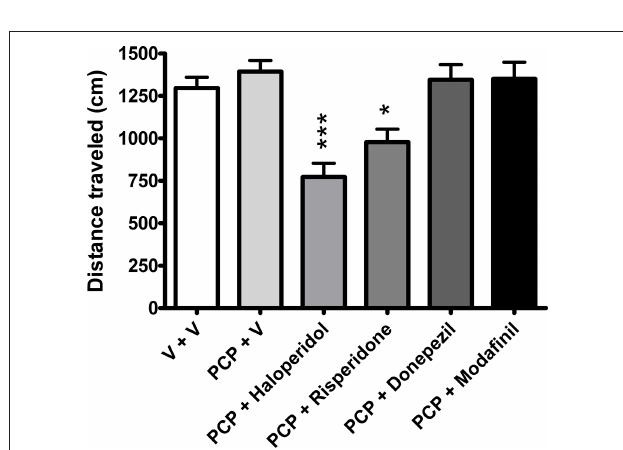
Figure 4 | The effects of vehicle ( n = 31), haloperidol (0.1 mg/kg, n = 9), risperidone (0.2 mg/kg, n = 12), donepezil (3 mg/kg, n = 12), and modafinil (64 mg/kg, n = 10) on Di ( T sub-chronically treated with PCP ( n = 33). Data expressed as mean + SEM. ### P < 0.001 versus vehicle-treated group; *** P < 0.001 versus PCP-treated group (one-way ANOVA followed by Bonferroni’s multiple comparison post hoc analysis).